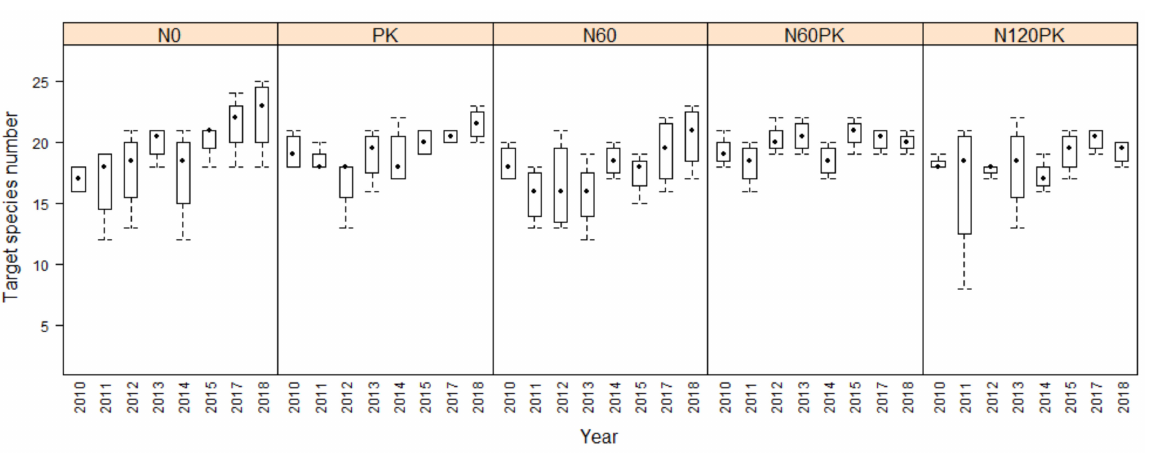
Figure 4. Development of the number of target species with different fertilization treatments between 2010 and 2018 (except 2016). There were no significant differences between treatments or years according to the generalized linear model (GLM).